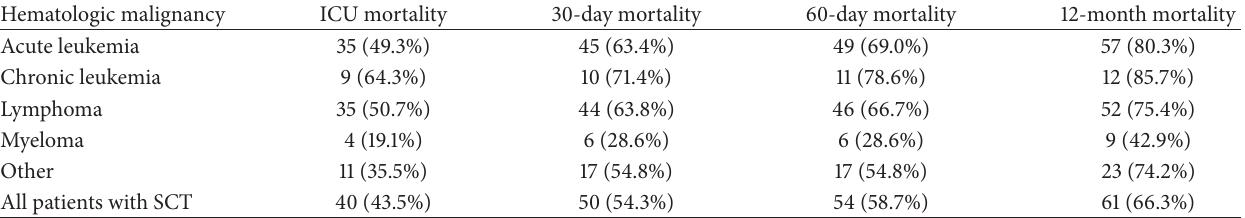
Table 4: ICU and long-term mortality by type of hematologic malignancy and previous stem cell transplant. Hematologic malignancy